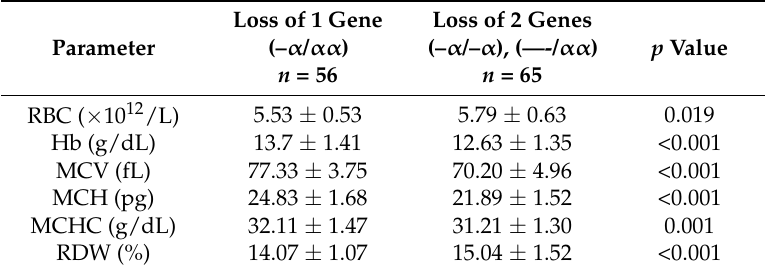
Table 3. Comparison of hematologic parameters in subjects with loss of 1 alpha gene and those with two genes affected. Data represent mean ± SD (standard deviation). p values less than 0.05 were considered statistically significant.